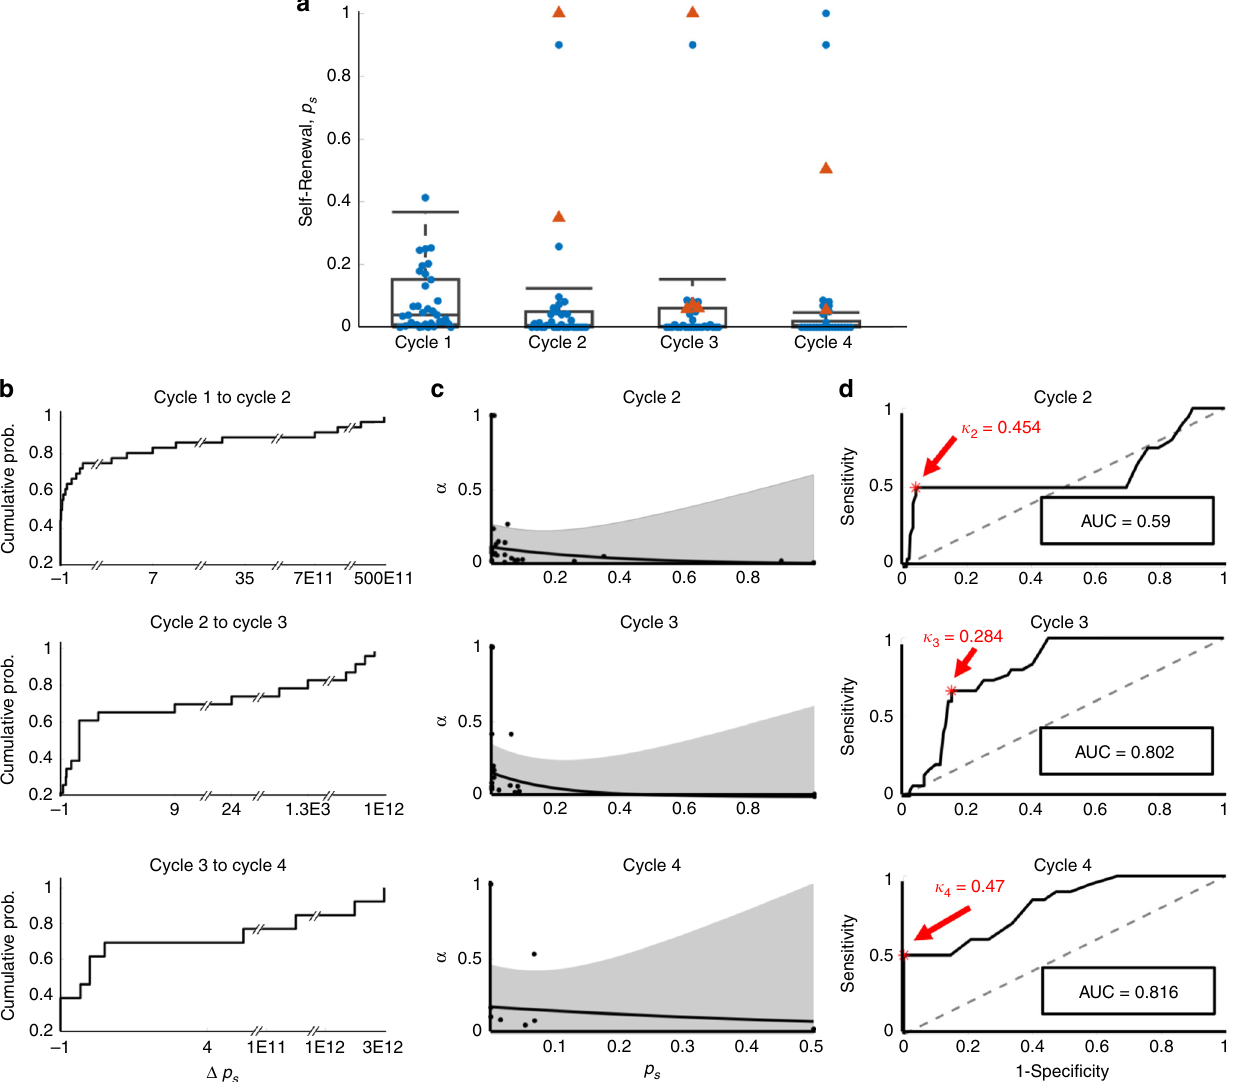
Fig. 2 Cycle to cycle parameter changes. a Cycle to cycle parameter distributions for p s (changes between cycles is not signi fi cant ( p > 0.05)) for n = 35, n = 35, n = 33, n = 30 patients in cycles 1 through 4, respectively. Boxplots show median including the 25th and 75th percentiles. The two-sample t test was used to calculate the statistical signi fi cance of the difference between the groups. Blue dots and red triangles denote responsive and resistant patients, respectively. b Cumulative probability of relative changes in p s between cycles. c α vs. p s fi t (black curve) and 95% con fi dence interval (gray). d Receiver operating characteristic curves for training predictions for cycles two through four. The resistance threshold κ that maximizes the accuracy and hence, predictive power, is shown in